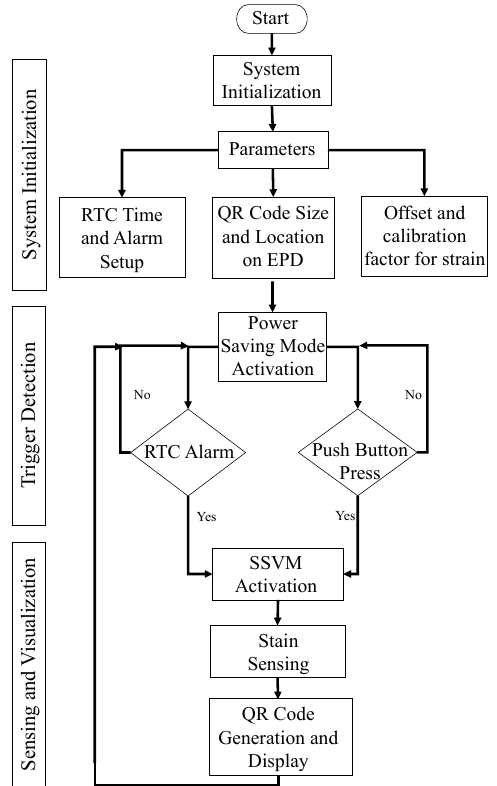
Figure 7. Integrated software framework flow for SSVM.